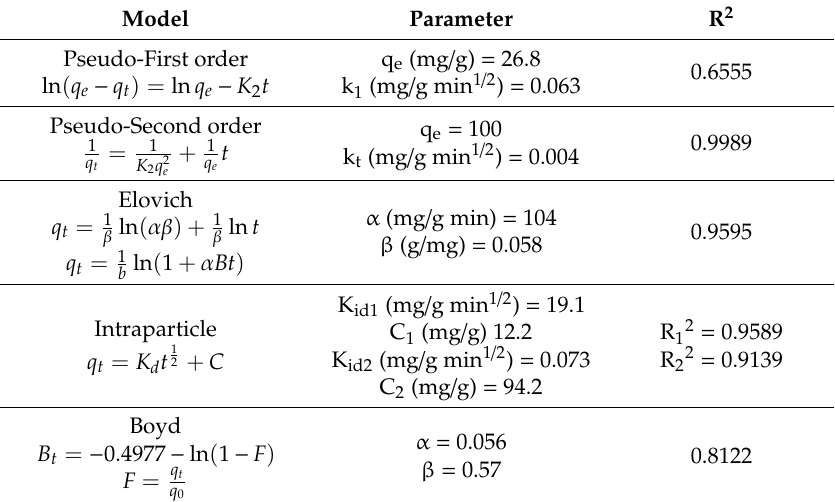
Table 3. Kinetic models and parameters investigated in the present